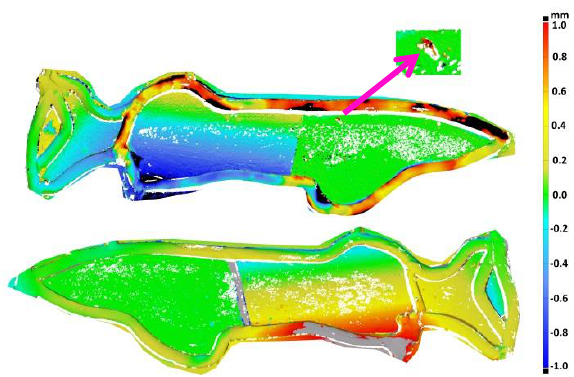
Koszewko. Top: comparison of the outside; bottom: comparison of the